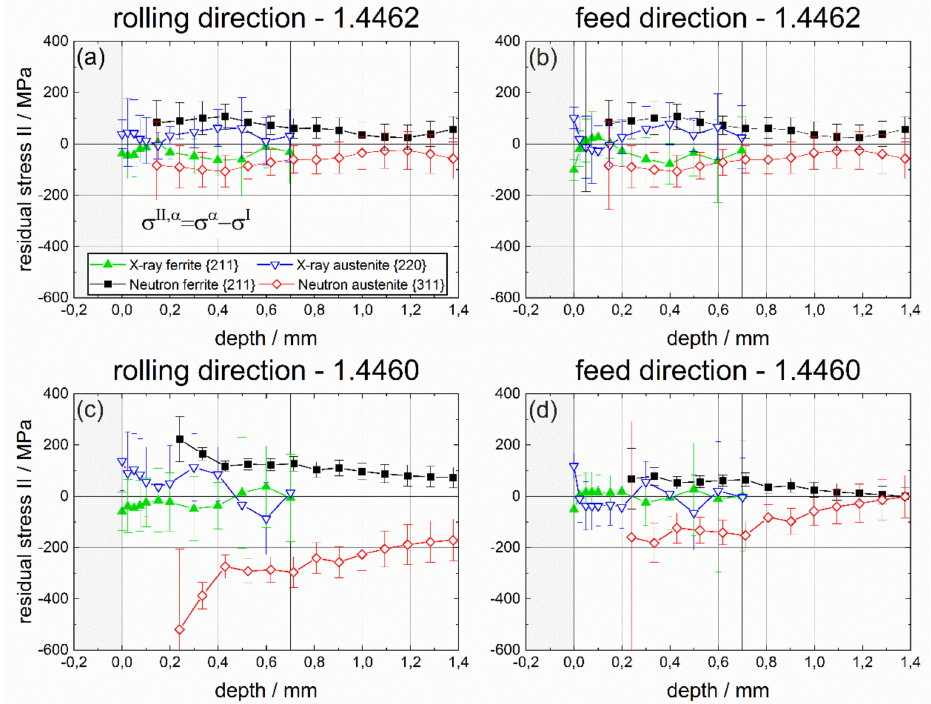
Figure 10. Phase-specific micro RS for ferrite and austenite determined by means of neutron diffraction and X-ray diffraction in both directions (in the rolling direction (DR) and in the feed direction (FD)) for both materials, i.e., for duplex steel 1.4462 with a phase ratio of 50:50 and for duplex steel 1.4460 with a ferrite to austenite ratio of